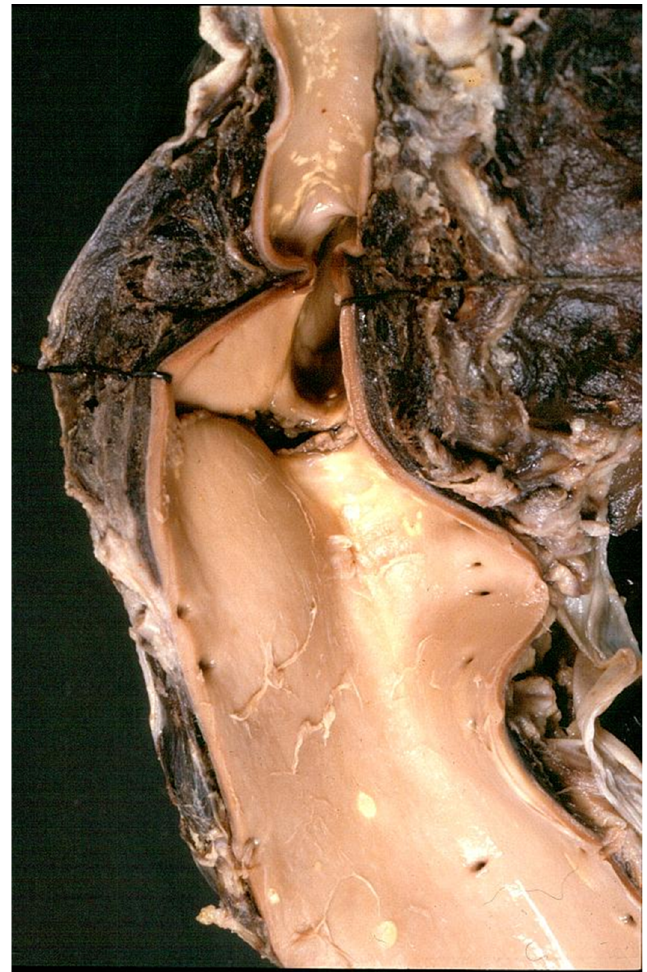
Figure 30. Fatal case of traumatic transmural aortic rupture at isthmic level by blunt